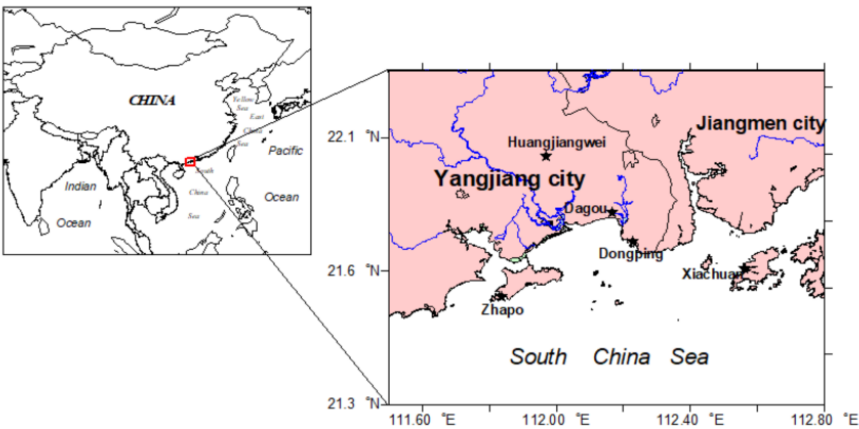
Figure 1. Sampling stations in Yangjiang and the adjacent areas.